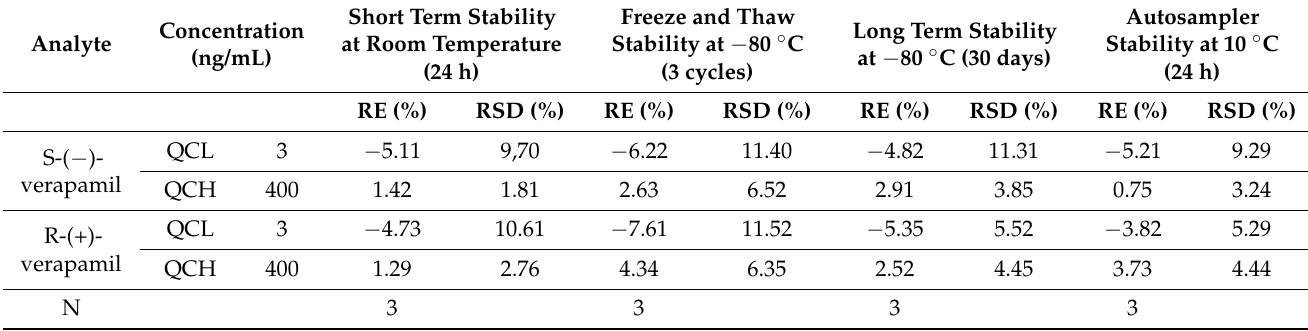
a mean of six measurements.